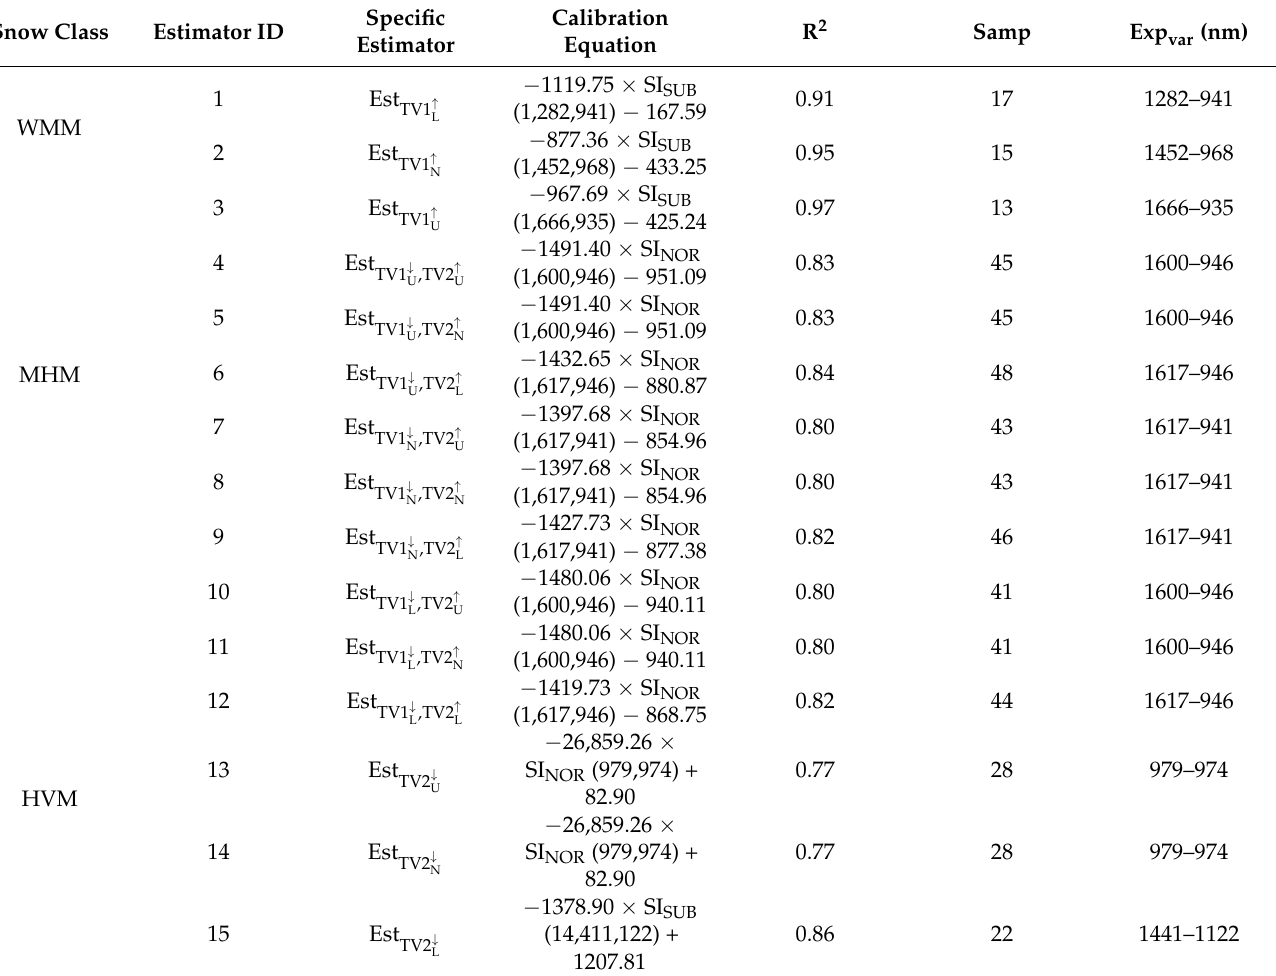
Table 3. Calibration equations for each specific estimator. R 2 is the coefficient of determination of the multivariate regressions; Samp is the size of the training dataset of each estimator; Exp the explanatory variable; U, N, and L are the Upper, Nominal and Lower thresholds; the arrow ( ↑ ) indicates an estimator trained with data superior to the threshold; and the downward arrow ( ↓ ) indicates an estimator trained with data inferior the threshold; the colors light blue, marine blue, and dark blue refer to the experts used to calculate the snow density of the WMM, MHM and HVM classes,